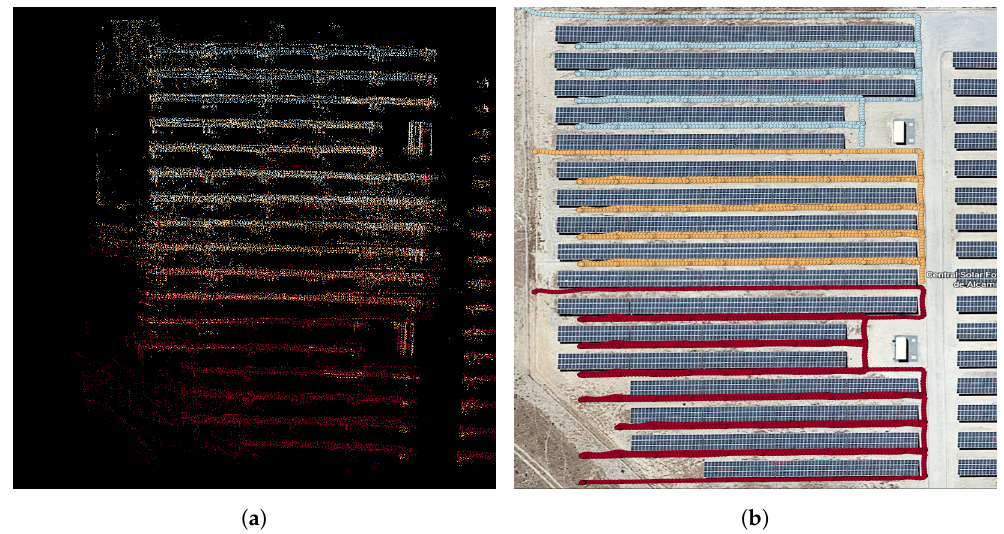
Figure 8. The results of an isolated iteration of simulated experiments with N a = 3. ( a ) Merged map. ( b ) Path taken.